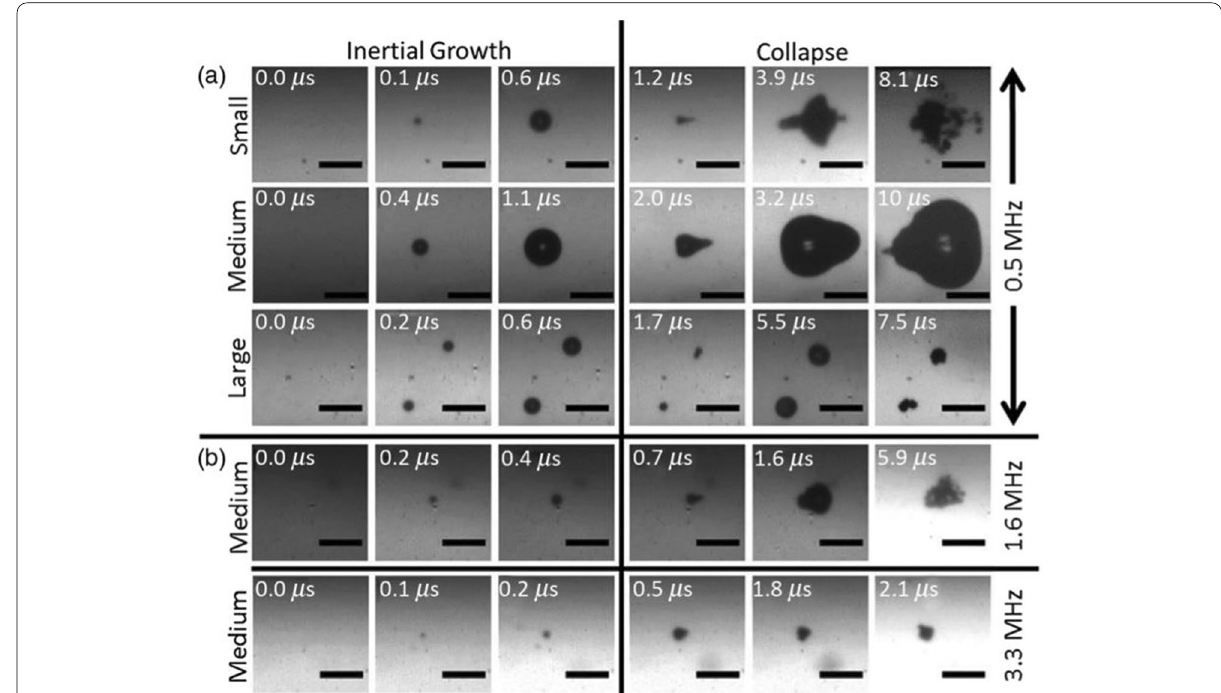
Fig. 1 High speed camera observations of microbubbles generated by polymer nanocups with different sizes and under ultrasound insonation with a frequency of 0.5, 1.6, or 3.3 MHz. Adapted from reference [45], Copyright 2016, American Physical